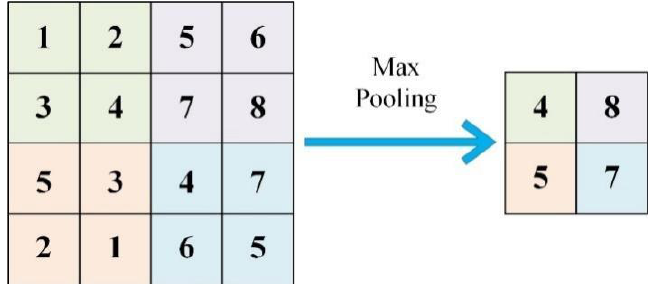
Figure 3. Schematic diagram of max pooling operation.